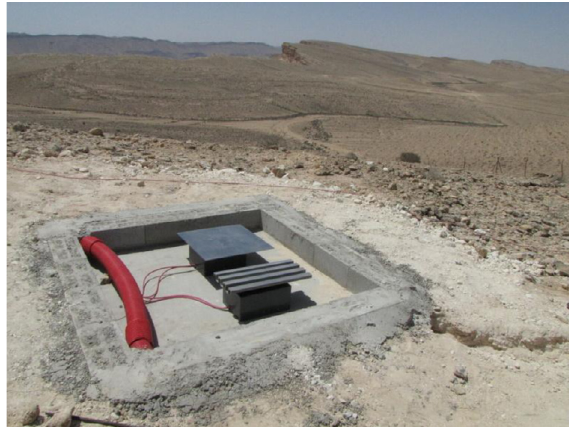
Figure 1. The GDACCS current density sensors at Mitzpe Ramon, Negev